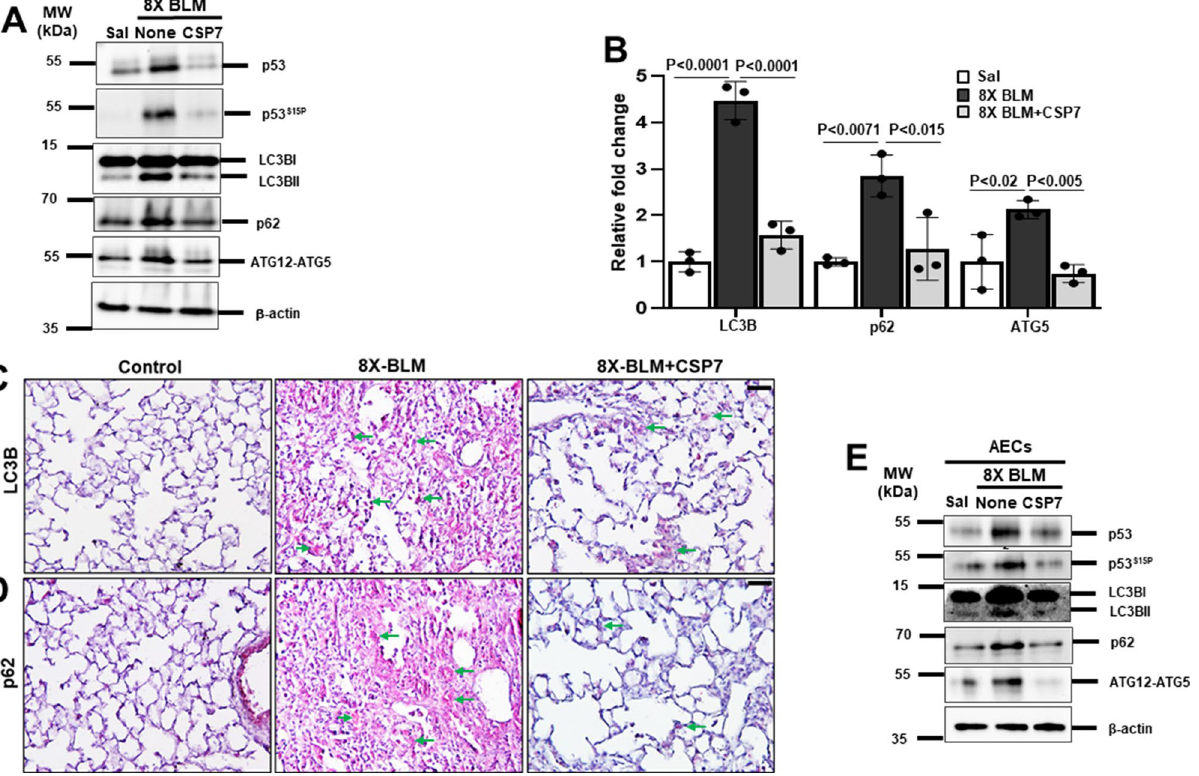
Figure 4. CSP7 mitigates autophagy dysregulation in 8X-BLM-induced PF. ( A ) Representative western blot images showing the expression of p53, p53 S15P , LC3BII, p62 and ATG12-ATG5 in lung homogenates of CSP7 treated WT mice (n = 5) with 8X-BLM-induced existing PF. β-actin serves as loading control. MW: Molecular weight. kDa: Kilodalton. ( B ) Bar graph showing increased expression of LC3B, p62 and ATG5 mRNA in the lungs of 8X-BLM-PF WT mice, which is inhibited upon CSP7 treatment. Representative immunohistochemistry images showing inhibition of ( C ) LC3B and ( D ) p62 expression by CSP7 in lungs of WT mice with 8X-BLM-PF. Scale bar: 20 μm. ( E ) Representative immunoblot images showing inhibition of p53, p53 S15P , LC3BII, p62 and ATG12-ATG5 expression in AECs isolated from WT mice with 8X-BLM-induced existing PF treated with CSP7 in vivo. β-actin serves as loading control. MW: Molecular weight. kDa: Kilodalton. Each experiment was repeated at least 2–3 times and data is presented as mean + SD and p values were obtained by one-way Anova with Turkey’s multiple comparison test and log-rank tests, compared to those from 8X-BLM left untreated (Fig. 4C–D). Further, CSP7 treatment reduced the elevated p53, p53 S15P , LC3BII, p62 and ATG12-ATG5 levels found in AECs isolated from 8X-BLM-PF mice to near-normal (Fig. 4E). Collectively, our findings show that CSP7 treatment attenuates BLM-induced lung fibrosis (Figure S3) and that the antifibrotic effects of CSP7 partly involves mitigation of aberrant autophagy in AECs. CSP7 prevents silica‑ and BLM‑induced autophagy dysregulation in hAECs in vitro. To test whether CSP7 prevents silica- and BLM-induced aberrant autophagy in hAECs, cells were treated with dif- ferent concentrations of silica for 72 h in vitro as we previously described 26 . We observed a dose-dependent increase in the expression of p53, p53 S15P , LC3BII, p62 and ATG12-ATG5 protein with maximum induction at 100 µg/mL of silica treatment (Fig. 5A). Treatment of hAECs with CSP7 (20 μM) at 24 or 48 h post-silica injury drastically reduced the expression of p53, p53 S15P , LC3BII, p62 and ATG12-ATG5 proteins (Fig. 5B). Similarly, treatment of hAECs with CSP7 (10 μM) 4 or 8 h after BLM (40 μg/ml) 17 decreased p53, p53 S15P , LC3BII, p62 and ATG12-ATG5 expression 24 h later (Fig. 5C). Since increased LC3BII level does not directly indicate change in autophagy, to determine autophagy flux, we next treated silica exposed hAECs with chloroquine (CQ) or vehicle in the presence or absence of CSP7. We observed a significant increase in the levels of LC3BII in CQ and silica co-treated hAECs compared to hAECs exposed to silica or CQ alone, indicating an induction of autophagy by silica in hAECs. Further, treatment of silica- and CQ-exposed hAECs with CSP7 also increased LC3BII levels (Fig. 5D), suggesting that CQ-mediated inhibition of autophagy is unaffected by CSP7. Similar results were also noted with co-treatment of CQ and BLM of hAECs (Fig. 5E). Since Cav1 is known to interact with autophagy proteins 27–29 , we sought how this interaction is altered during AEC injury and whether it is affected by CSP7 treatment. Consistent with elevated expression of Cav1 during silica- or BLM-induced AEC injury 26 , we found increased interaction of LC3BII and p62 Cav1 with both in hAECs with silica (Fig. 5F) or BLM (Fig. 5G) injury. These interactions were attenuated by CSP7 without interfering with the interactions between Cav1 and ATG5